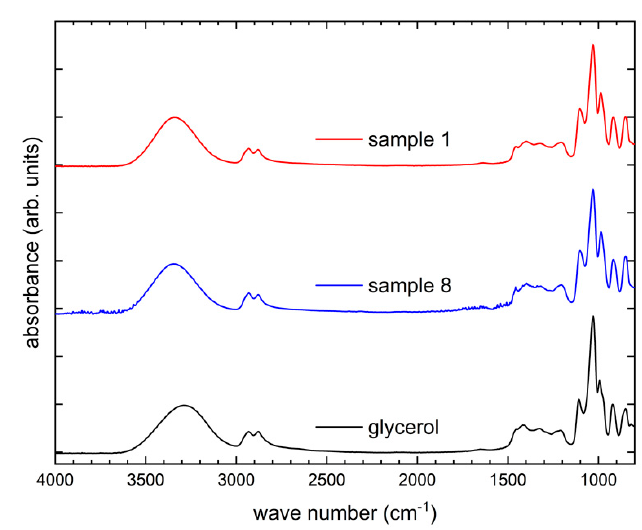
Figure 6. FTIR spectra of pure glycerol, the GPE of sample 8 with KI and I 2 solved in glycerol and the GPE of sample 1 composed of glycerol, KI, I 2 , and PEO. The graphs are shifted vertically for clarity.